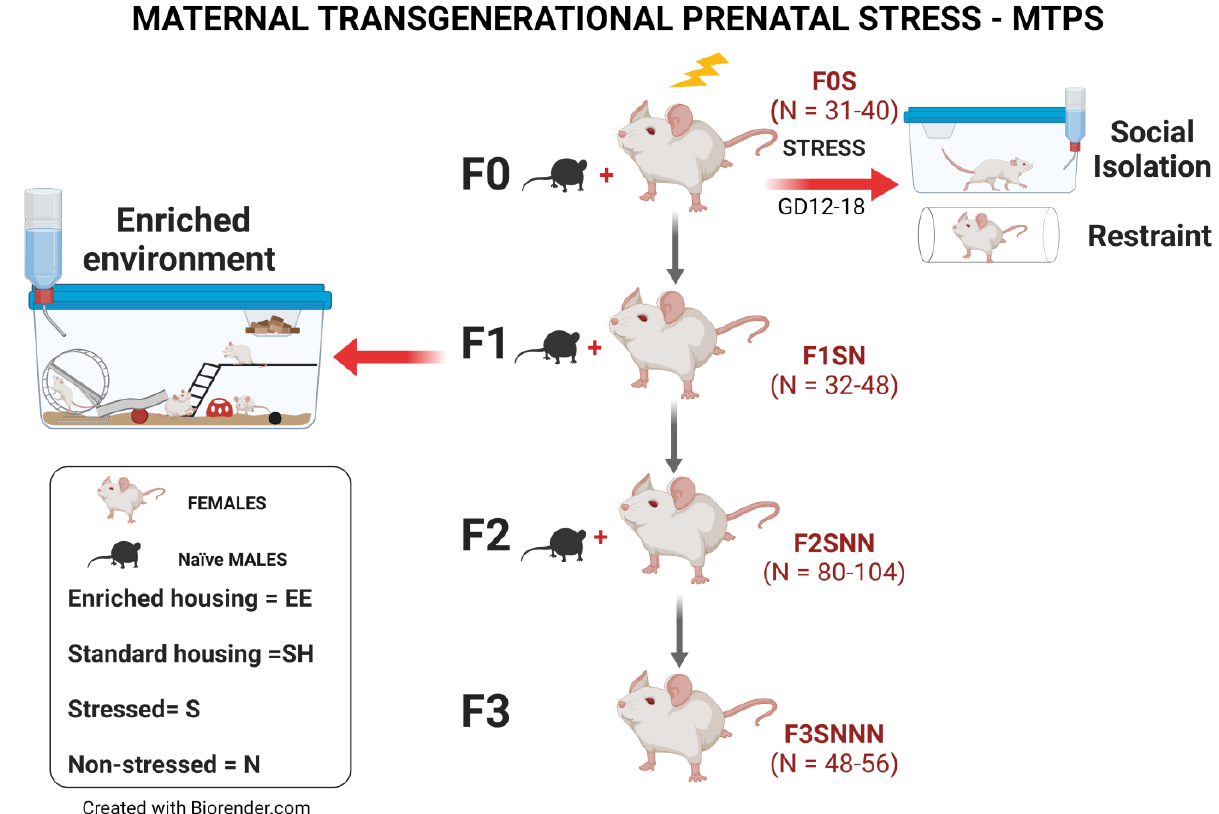
Figure 1. Maternal transgenerational prenatal stress experimental design. Flow chart illustrating that F0 pregnant dams were subjected to social isolation and restraint stress from GD12–18. EE housing included a combination of physical and sensorimotor enrichment and was implemented only in the F1 generation from weaning to GD20. The F1 (SN–EE) dams were then bred with nonstressed males to assess whether EE mitigated the negative effects of PNMS, and if these mitigative effects would be passed down to their F2 and F3 offspring. Therefore, the F2 and F3 generations were not directly exposed to EE housing or stress but experienced their transgenerational ancestral effects. F = filial generation. Created with Biorender.com (accessed on 15 July 2022).